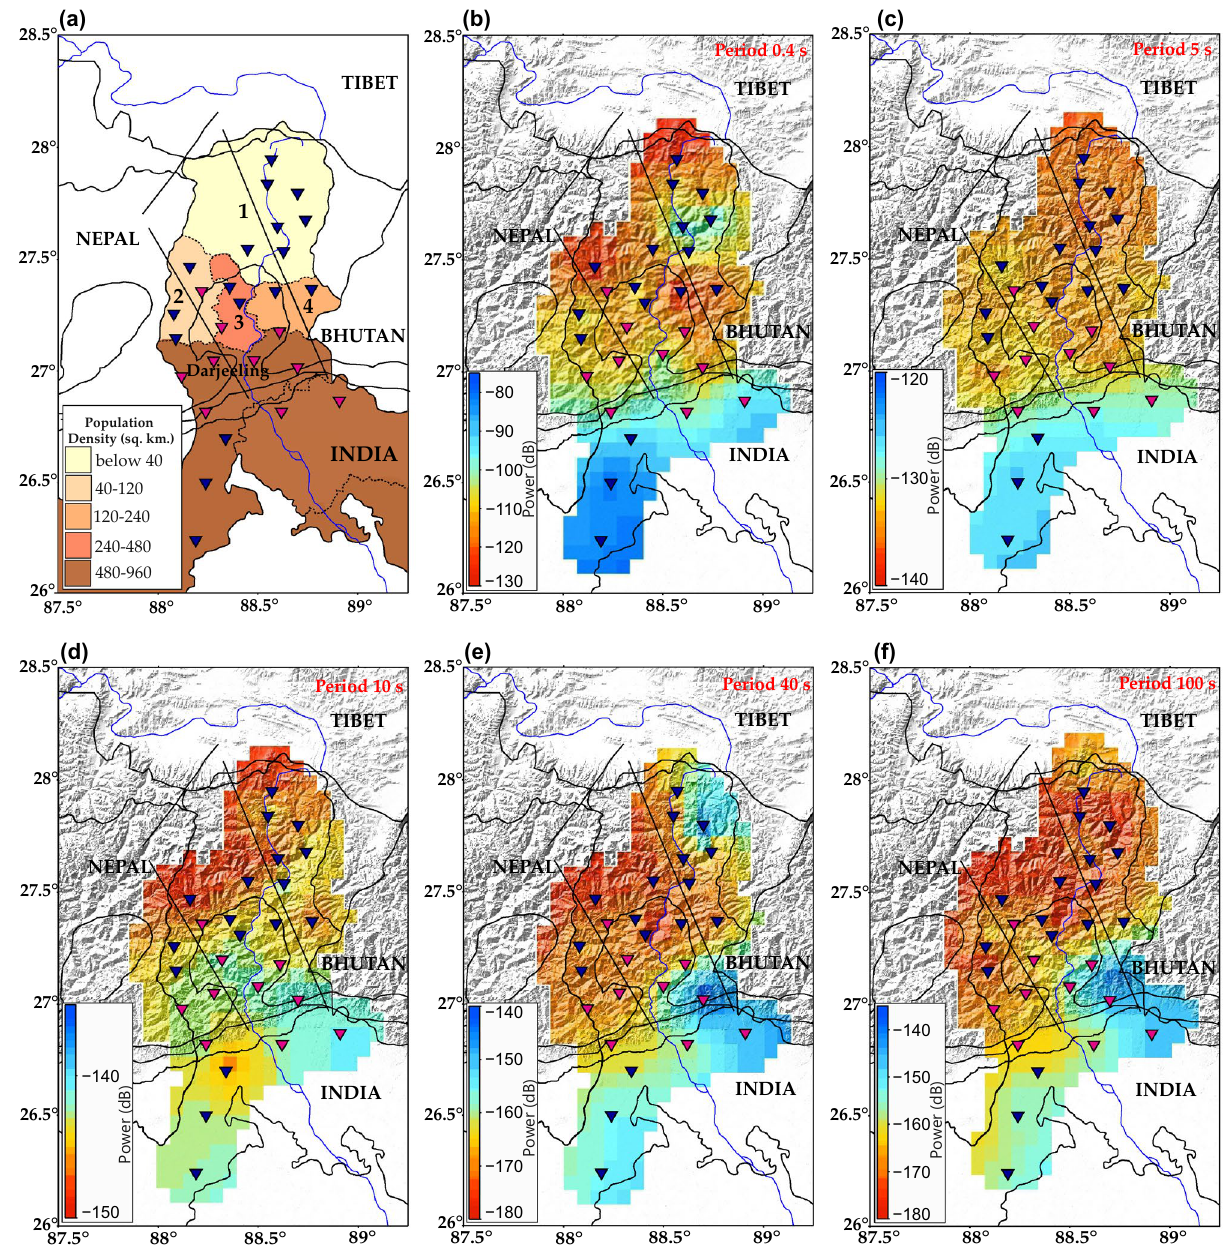
Figure 6. Representation of ( a ) the population density across the study area, and median Power Spectral Density (PSD) values of the ambient noise in the vertical component at different periods ( b ) 0.4 s, short-period, ( c ) 5 s, secondary microseismic period, ( d ) 10 s, primary microseismic period, ( e ) 40 s, intermediate period and ( f ) 100 s, long-period noise. The colour scales in each sub-figure, ( b – f ), representing PSD (dB), are different for each period to highlight the changes in the ambient noise levels across the Sikkim Himalaya. Stations with sensors installed on pier are represented with pink inverted triangles and stations with sensors buried are represented in blue inverted triangles. MFT: Main Frontal Thrust, MBT: Main Boundary Thrust, MCT: Main Central Thrust, 1: North Sikkim, 2: West Sikkim, 3: South Sikkim, 4: East Sikkim. Software used to generate the figure: Generic Mapping Tools (GMT) v6.0.0 40 median PSD values observed at the vertical component at different periods, 0.4 s, 5 s, 10 s, 40 s and 100 s, to evaluate the variation of noise at short-period, secondary microseism, primary microseism, intermediate period and long-period, respectively 5 . The spatial plots were generated by plotting the median PSD values, obtained for each station at the aforementioned periods, at the corresponding geographical location of the station using the nearest neighbour interpolation method with a search radius of 18 km. A comparative study of the spatial median PSD plots shows that short-period and cultural noise is higher in the data recorded at stations located in the south than for those located in central and north Sikkim Himalaya (Fig. 6b). Microseism noise is higher